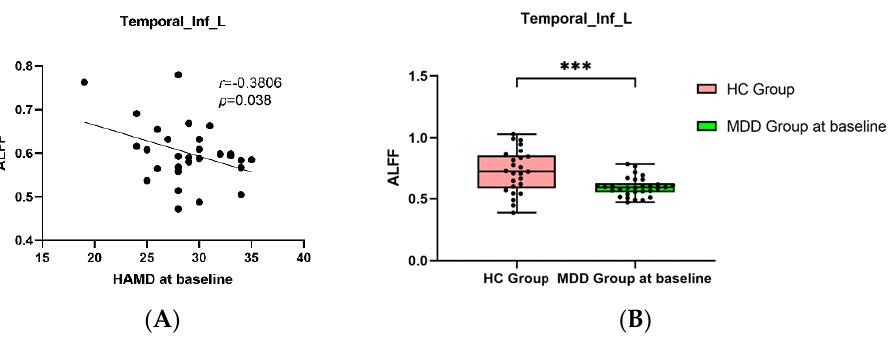
Figure 5. ( A ): The negative correlations between HAMD scores at baseline and ALFF in the Temporal_Inf_L ( p = 0.038). ( B ): MDDs showed decreased ALFF in Temporal_Inf_L compared with HCs (*** p ＜ 0.001).